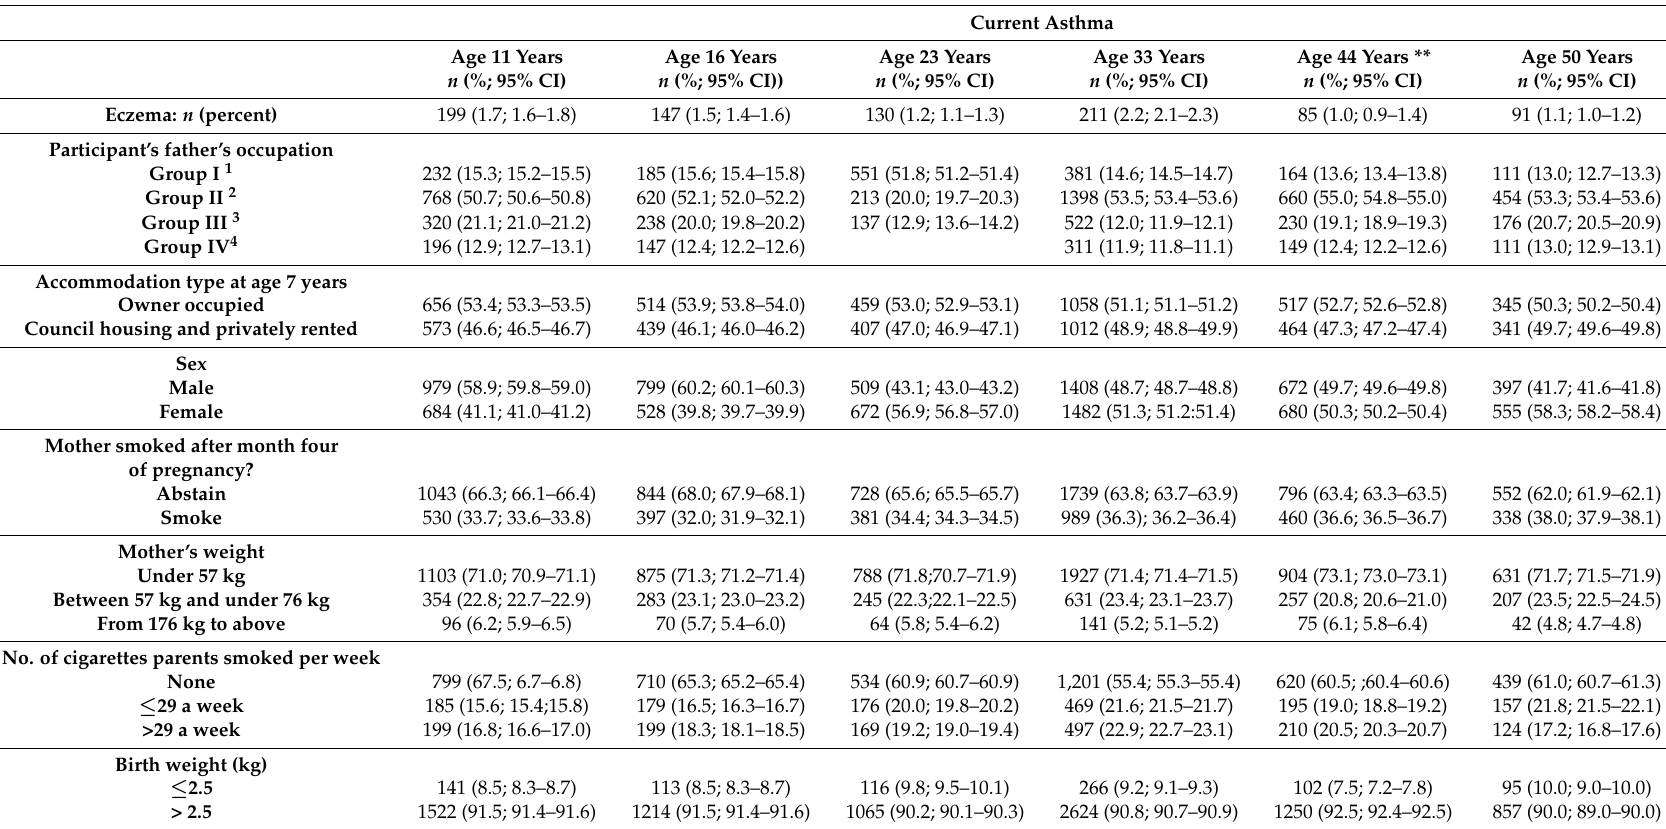
Table 1. Summary statistics of covariates across asthma outcome(s) from age 11 to 50 years according to the participants’ responses to the birth cohort study